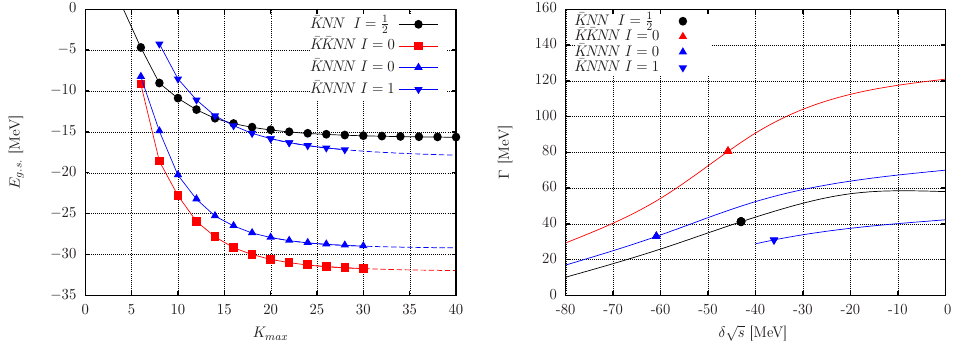
Figure 5. Left: binding energies of ¯ K and ¯ K ¯ K few-body quasibound states from Ref. [13] calculated self- consistently and plotted here as a function of the maximal total grand angular momentum K max in the hyper- spherical basis. Right: ¯ KN → π Y widths (9) plotted as a function of δ